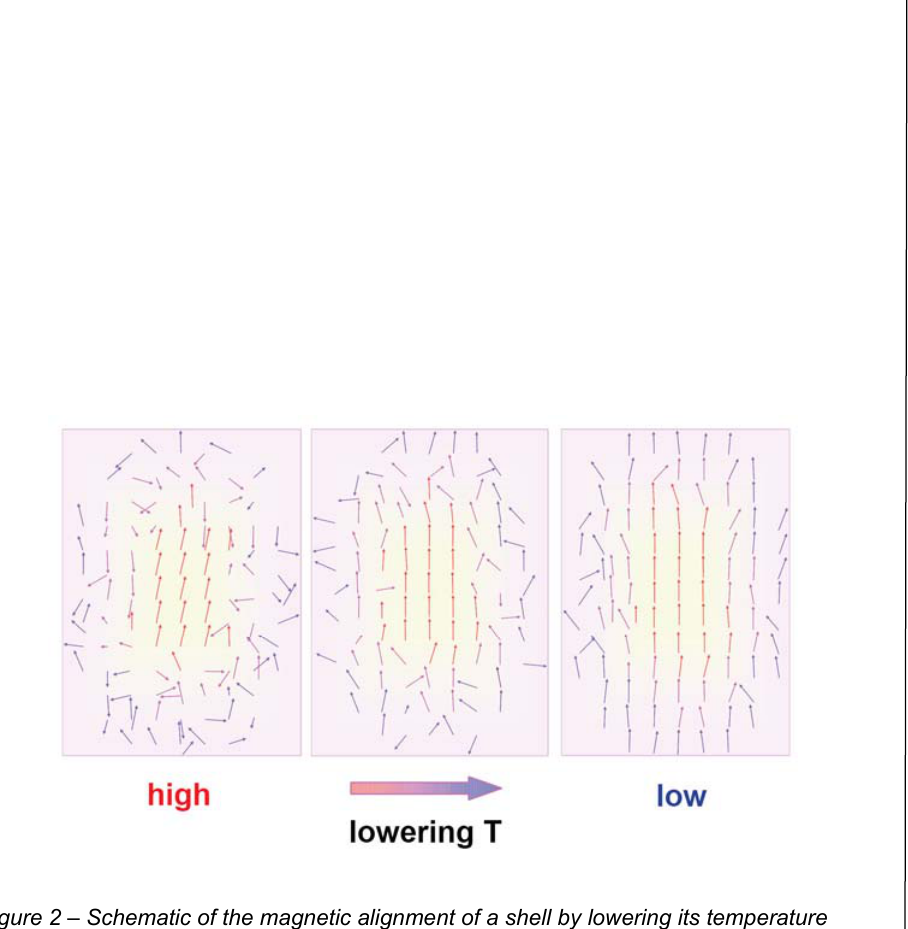
Figure 2 – Schematic of the magnetic alignment of a shell by lowering its temperature Рис . 2 – Схема магнитного выравнивания оболочки при снижении